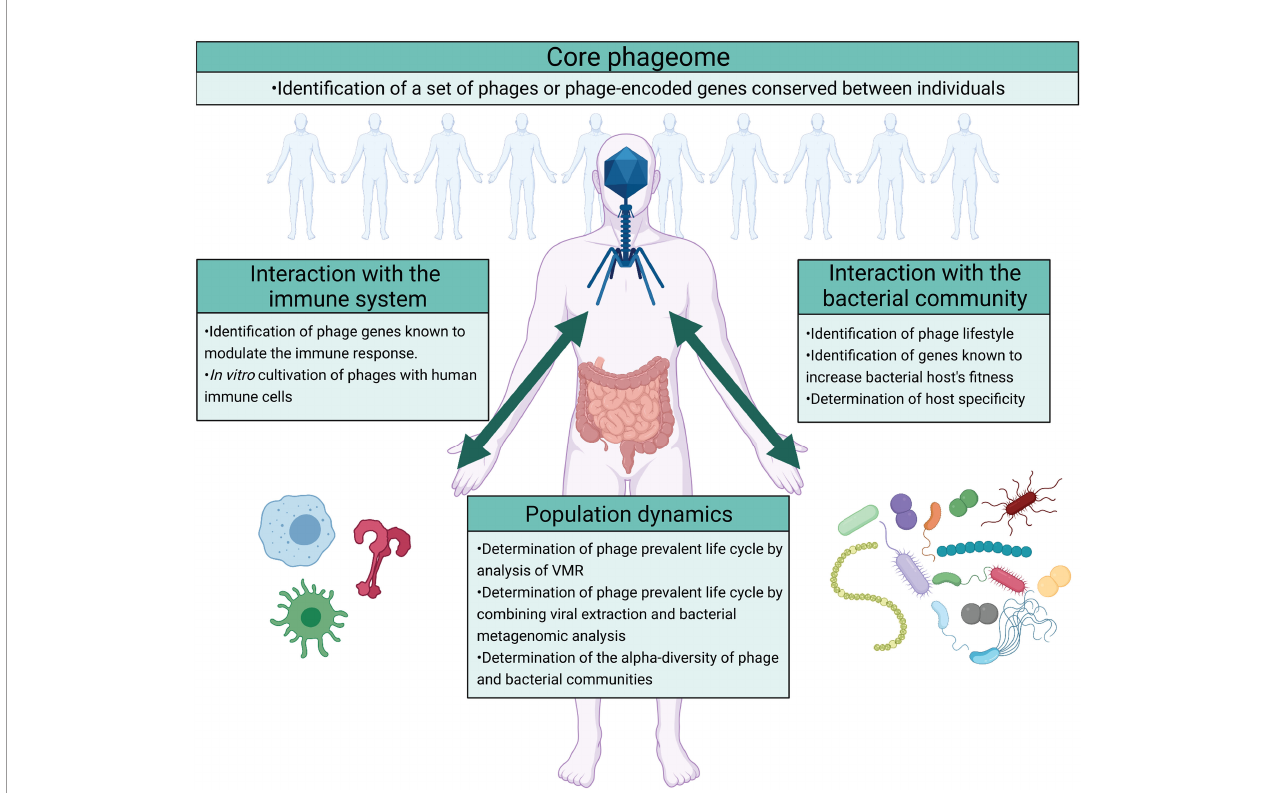
FIGURE 4 | Future directions on the study of the ecological roles of phages in the gut ecosystem. The impact of phages on the gut ecosystem can be studied by focusing on four different questions regarding the existence of a core phageome, phage ’ s interaction with the bacterial community, phage ’ s interaction with the host immune system, and the population dynamics that result. The identi fi cation of a core phageome would simplify the study of the gut phageome allowing a more targeted analysis. Moreover, the impact of phages on the gut ecosystem can arguably be identi fi ed by analyzing their interaction with the bacterial community and the host immune system. In addition to determining the interaction between phages, the bacterial community, and the immune system, studying the population dynamics that results would describe the outcomes of these interactions. In the fi gure are suggested different methods that can be used to answer these questions. Image created with